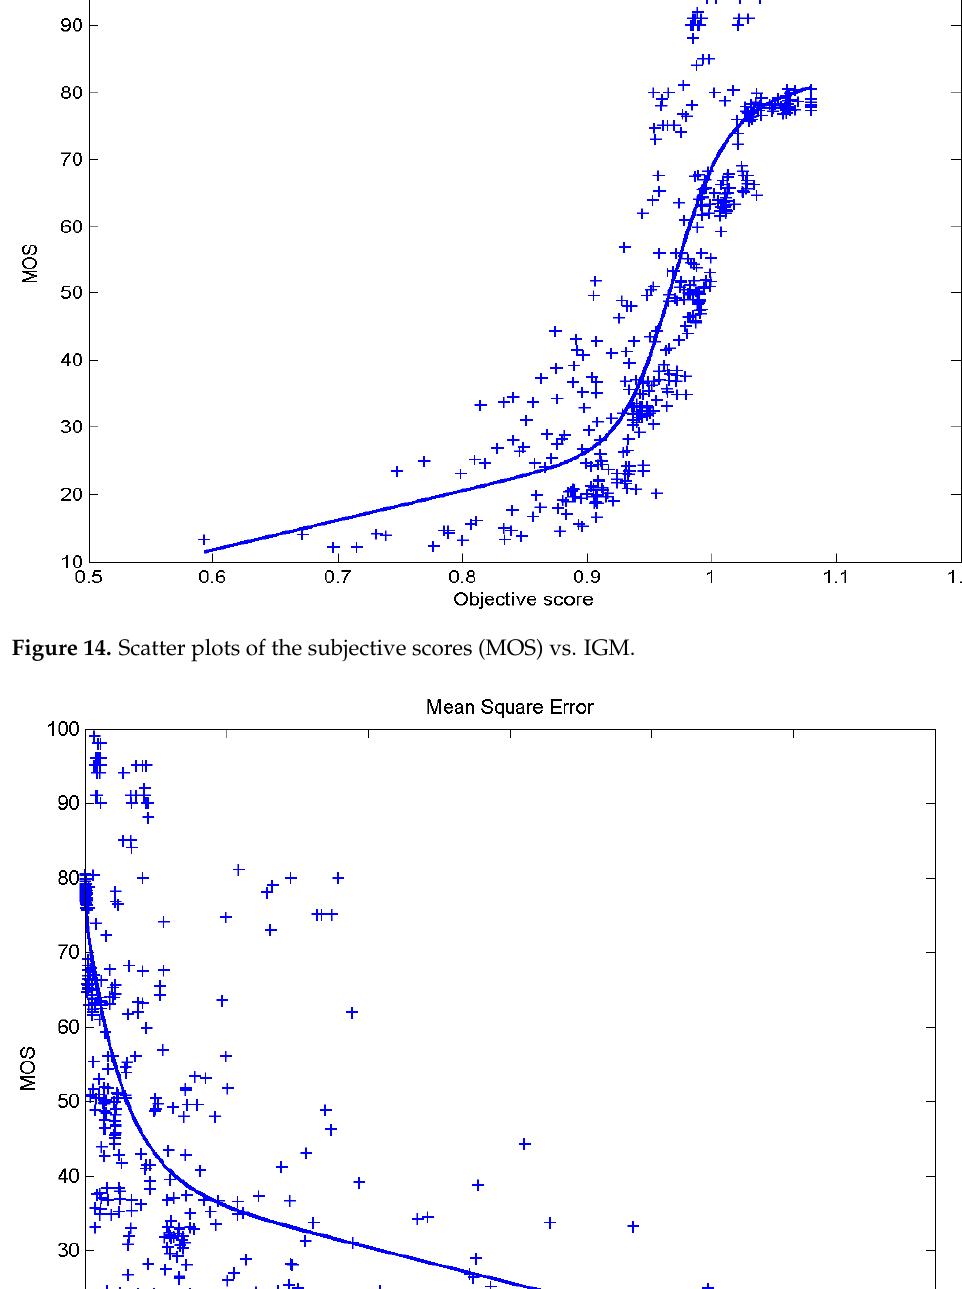
Figure 15. Scatter plots of the subjective scores (MOS) vs. MSE.